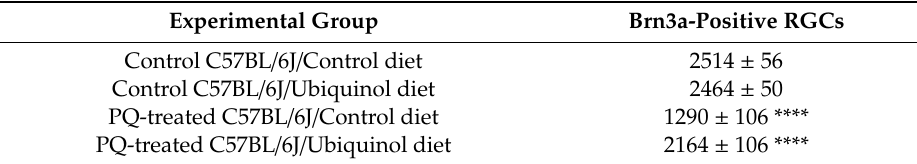
PQ-induced C57BL / 6J mice supplemented with control